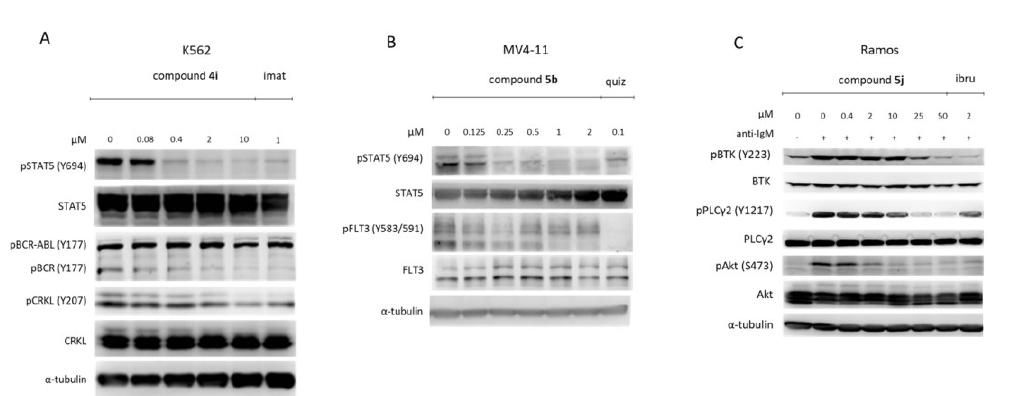
Figure 12. The effects of compounds 4i , 5b and 5j in cell lines. K562 cells treated with 4i ( A ), MV4-11 with 5b ( B ) and Ramos with 5j ( C ). Cells were treated with vehicle or the indicated concentration of the compound for 4 h. Imatinib (imat, 1 µM), quizartinib (quiz, 0.1 µM) and ibrutinib (ibru, 2 µM) were used as positive controls. Ramos cells were stimulated with anti-IgM (5 µg/mL) for 10 min before harvesting. The cells were lysed, and the proteins were detected by immunoblotting. Tubulin was used as the loading control.